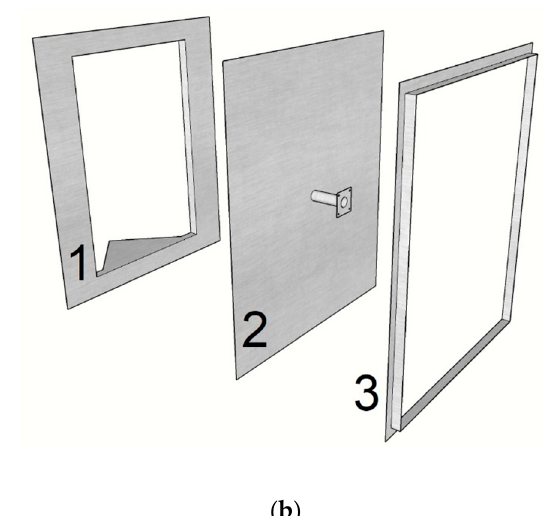
Figure 2. Special steel cover: ( a ) steel cover prepared to be connected to the specimen; ( b ) three individual parts of the steel cover.